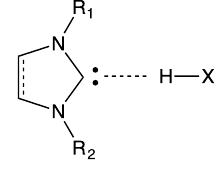
Figure 8. NHC hydrogen bond.